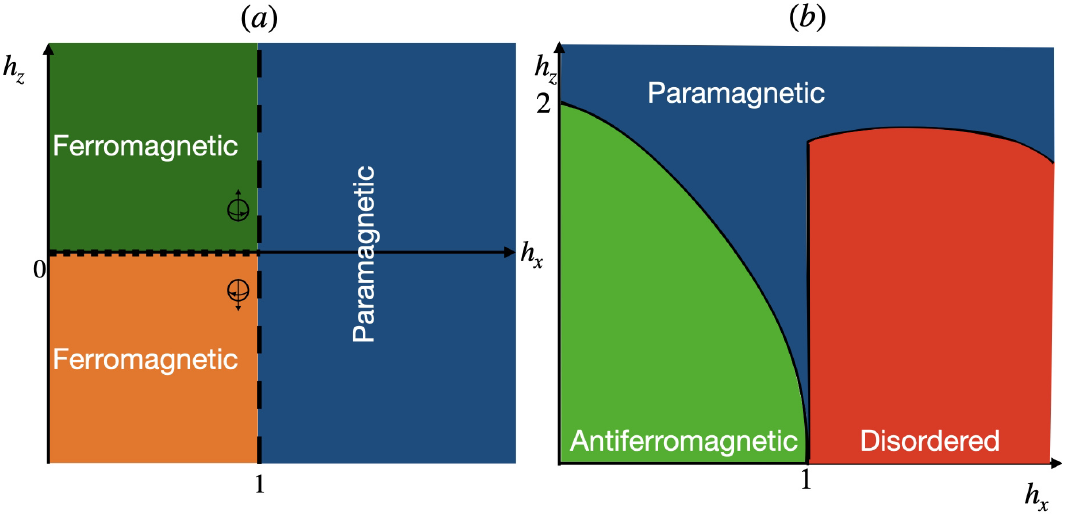
Figure 1: Panel (a): phase diagram of the ferromagnetic 1-D Ising chain with lon- gitudinal and transverse magnetic fields. Panel (b): phase diagram of the antiferro- magnetic 1-D Ising chain with longitudinal and transverse magnetic